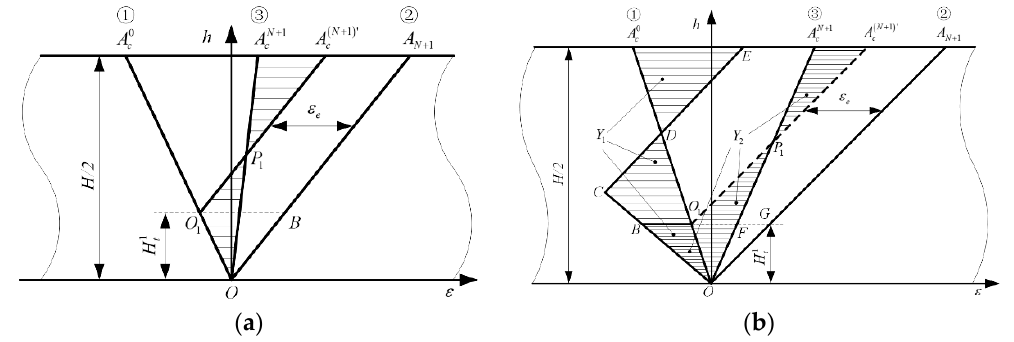
Figure 3. Evolution of residual stress in the first bending. ( a ) A sheet without initial residual stress and ( b ) a sheet with initial residual stress.